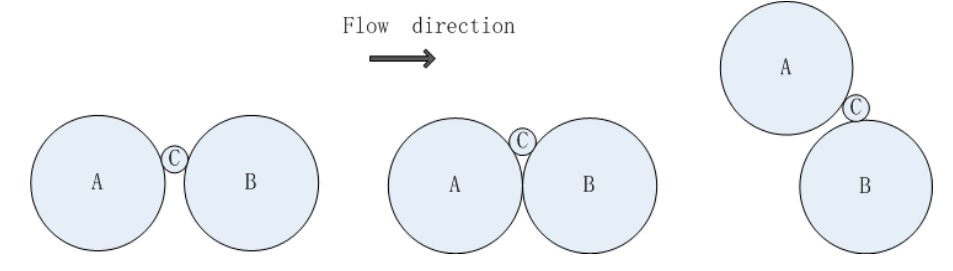
Figure 1. The randomness of particle position.